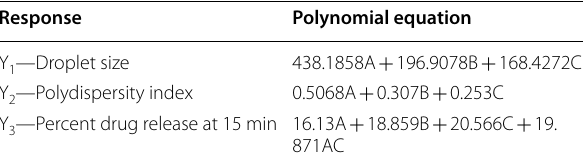
Table 2 Polynomial equations for the